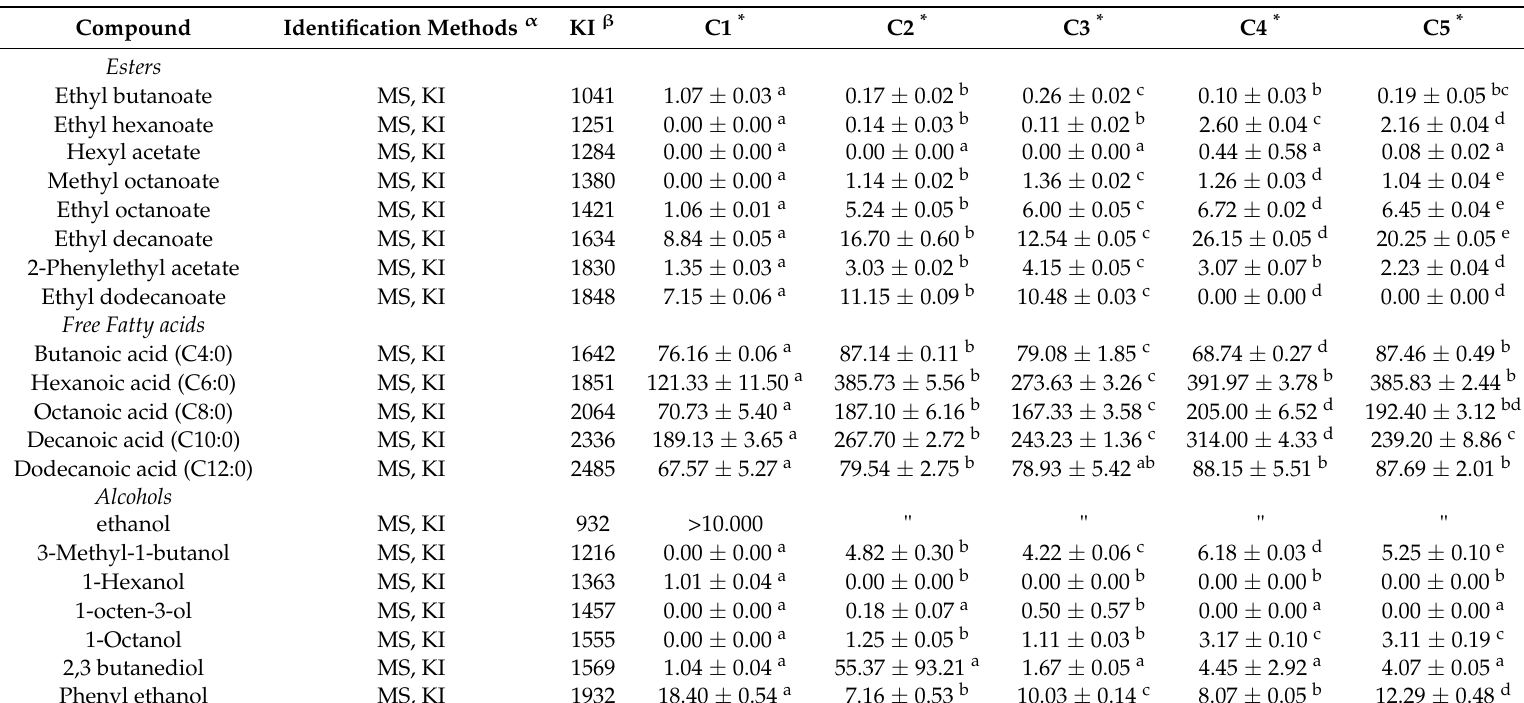
Table 2. Major aroma-related compounds ( µ g/kg of cheese) detected in Feta-type cheeses during refrigerated storage (30th day of storage at 4 ◦ C) by solid-phase microextraction (SPME) GC-MS